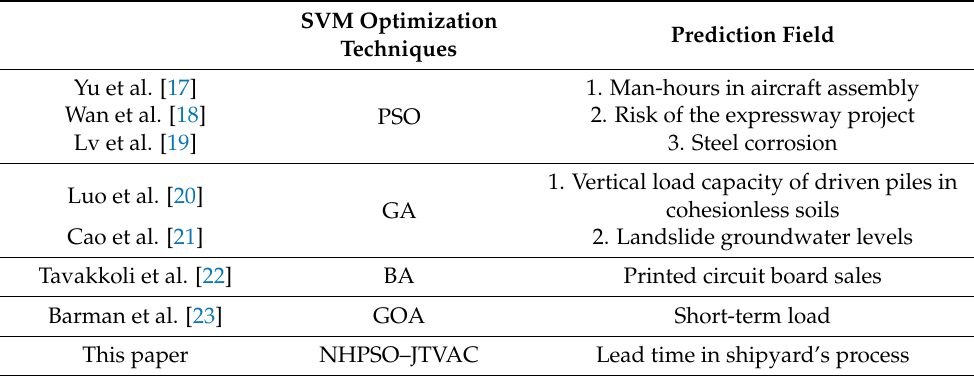
Table 1. Research literature on SVM optimization